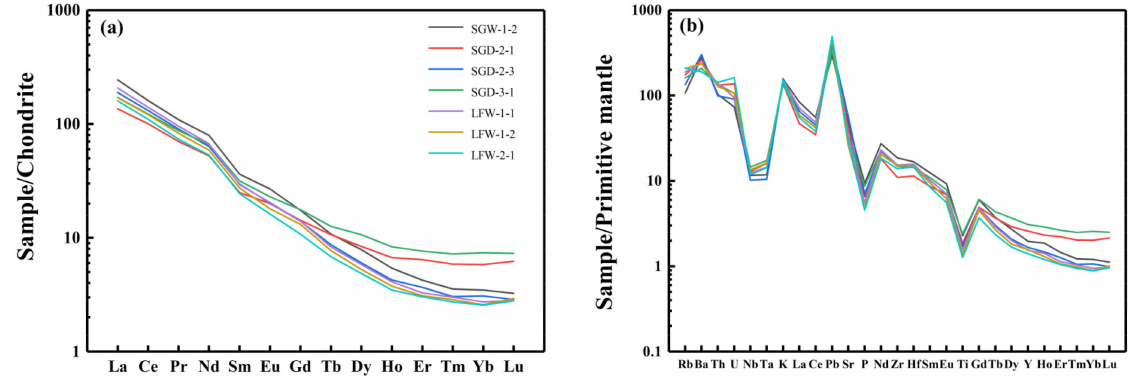
Figure 4. Chondrite-normalized REE patterns ( a ) and primitive mantle-normalized trace element spider diagram ( b ). Chon- drite and mantle-normalized values were taken from [44,45].